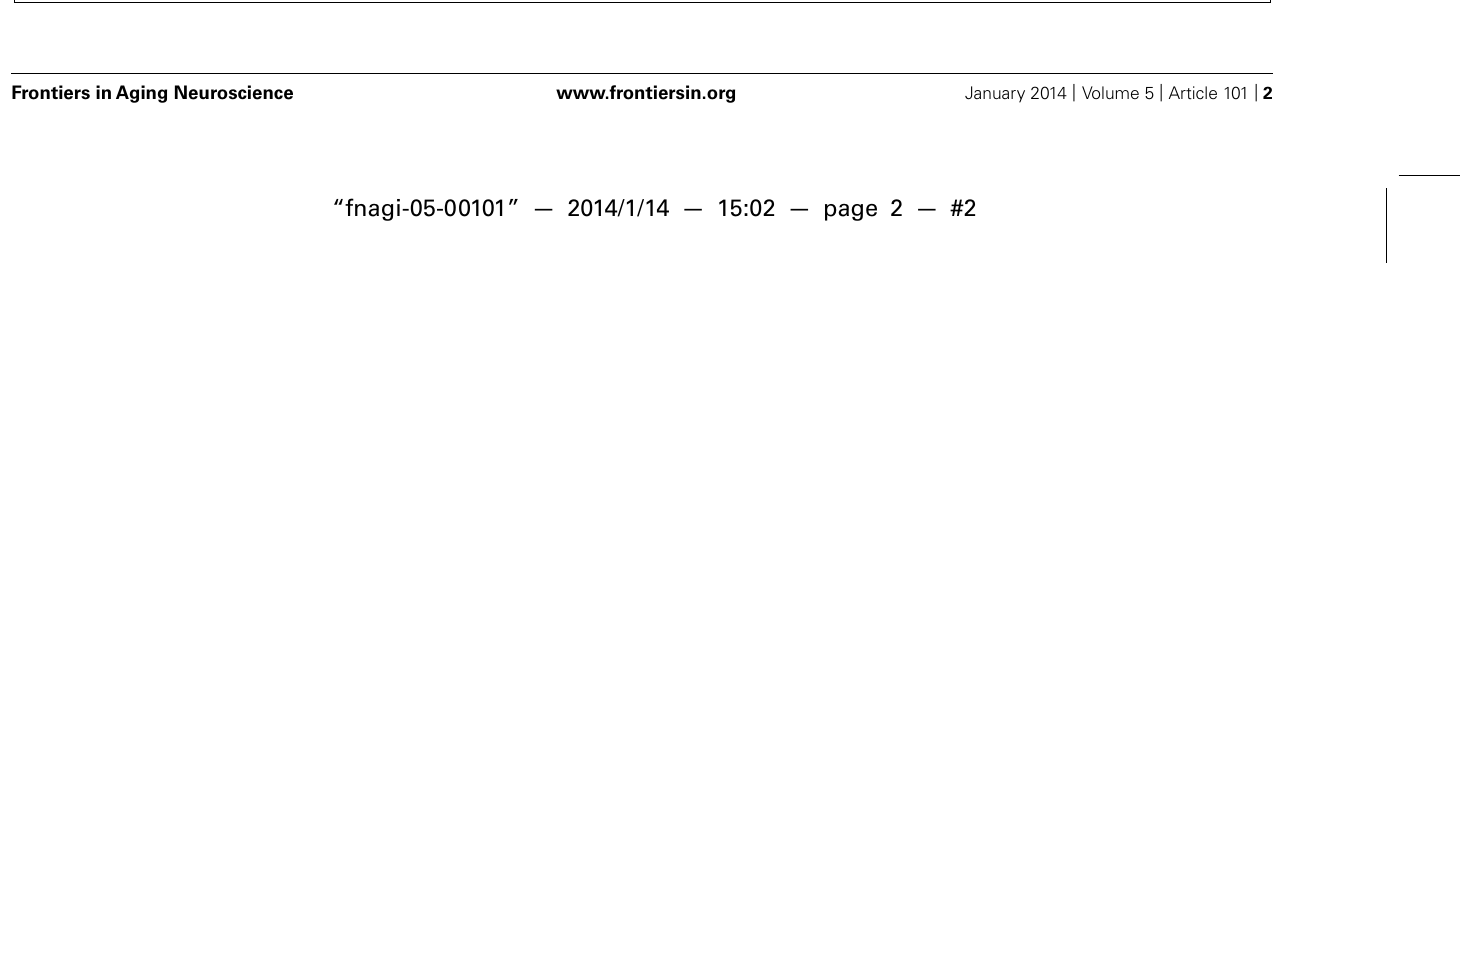
FIGURE 1 | Experimental setup. (A) Hemisphere, forehead- and chin-rest. In (B) , the front panel is removed to illustrate the projection of the images into the cupola.The images are generated with a miniature projector positioned in the upper part of the hemisphere and reflected by a spherical mirror in the lower part (Nef etal.,